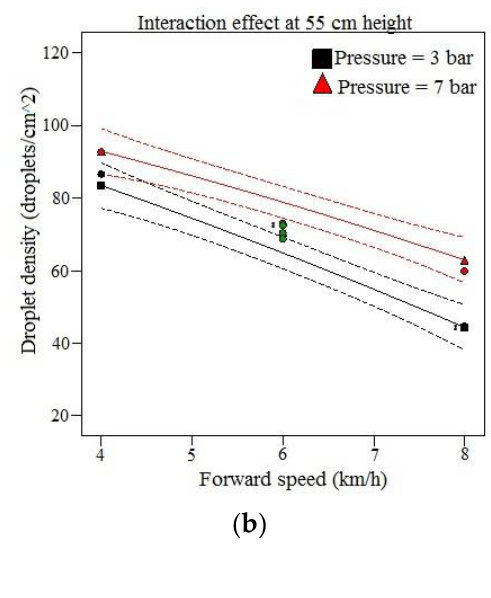
( c ) Figure 7. Droplet density: ( a ) relationship between forward speed and spray height at 5 bar pressure; ( b ) relationship between forward speed and pressure at 55 cm spray height; ( c ) relationship between spray height and pressure at 6 km/h speed.